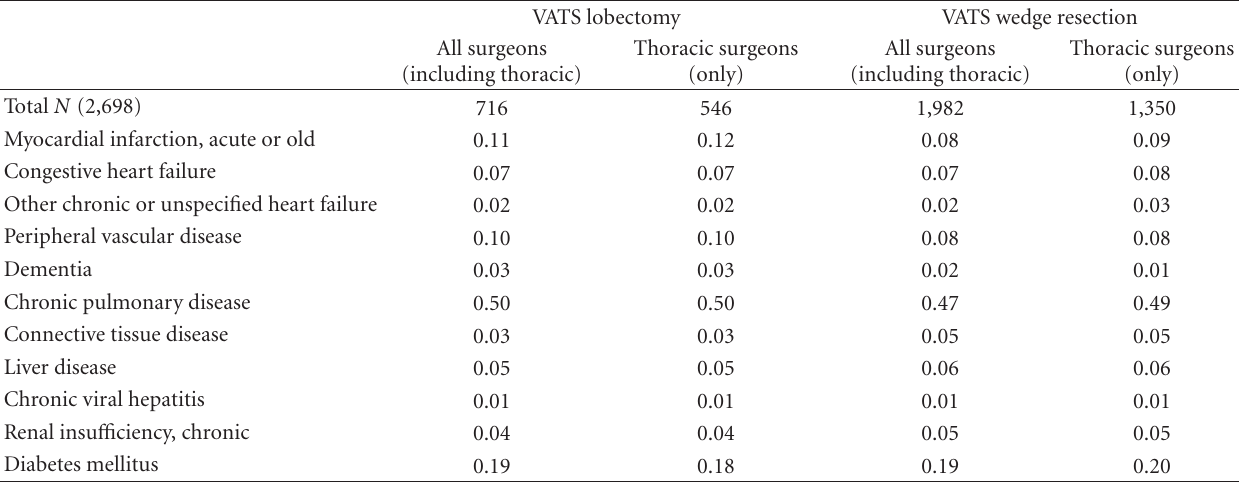
Table 2: Comorbid conditions ∗ , ∗∗ .